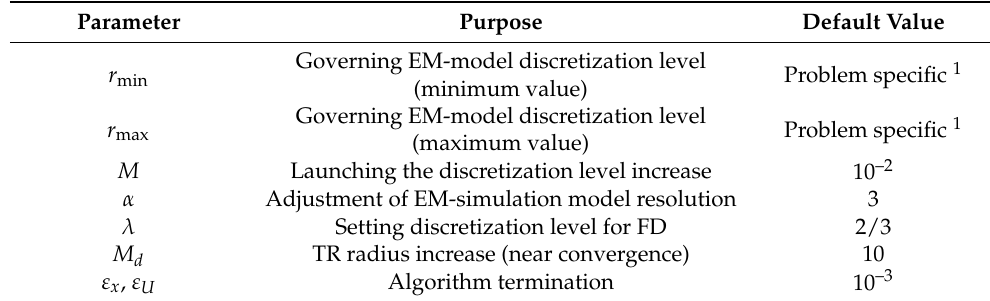
Figure 1. Operational flow of the proposed optimization-based miniaturization framework with multi-resolution EM simulations (one-headed arrows indicate the procedure flow, whereas two- headed arrows show where the procedure accesses the EM solver). Table 1. Control parameters of the proposed Algorithm 1: Operation of the proposed multi-fidelity size reduction algorithm.